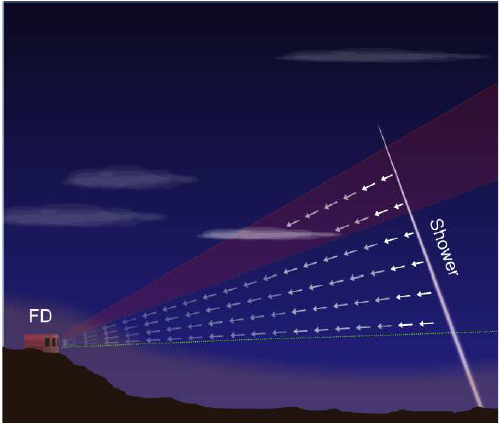
Figure 2. Schematic view of the path of the light emitted in the atmosphere during the development of an air shower towards one the FD sites.